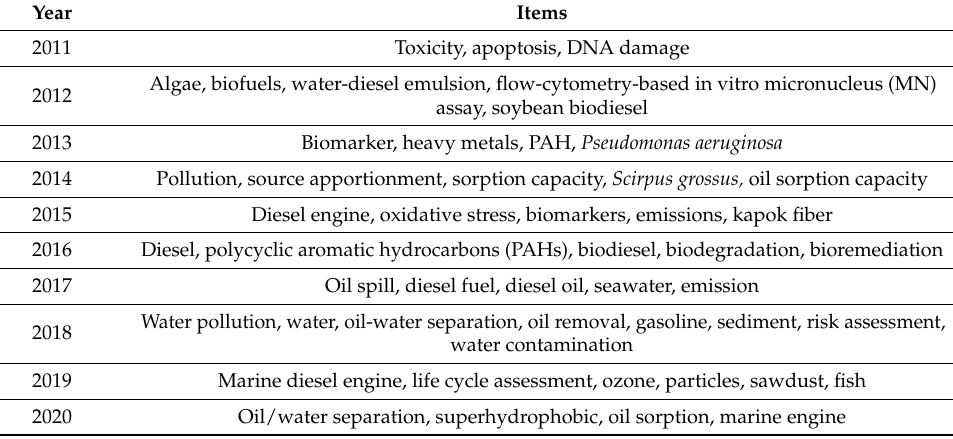
Table 4. Trend topics from 2011 to 2020 based on author’s keywords. Items shown have word minimum frequency of